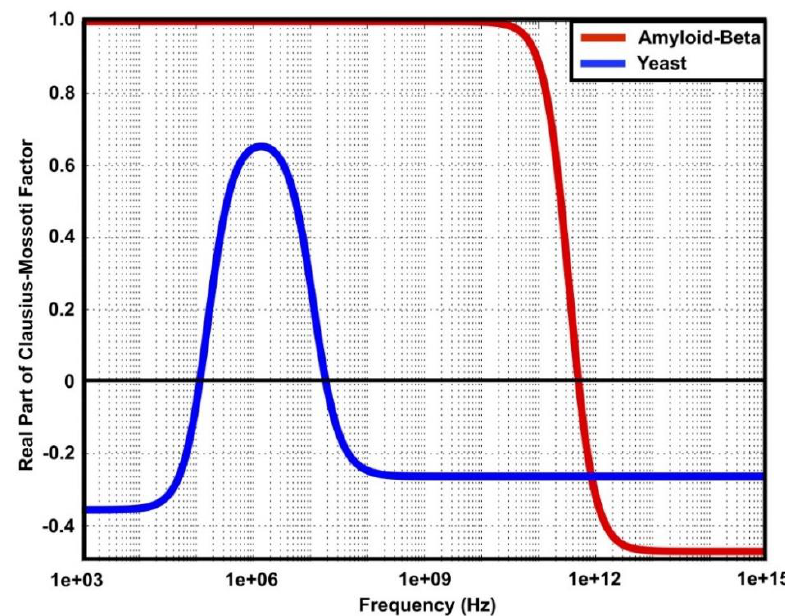
Figure 9. Re[ f CM ] of amyloid-beta protein and yeast cells in deionized water (DIW) .